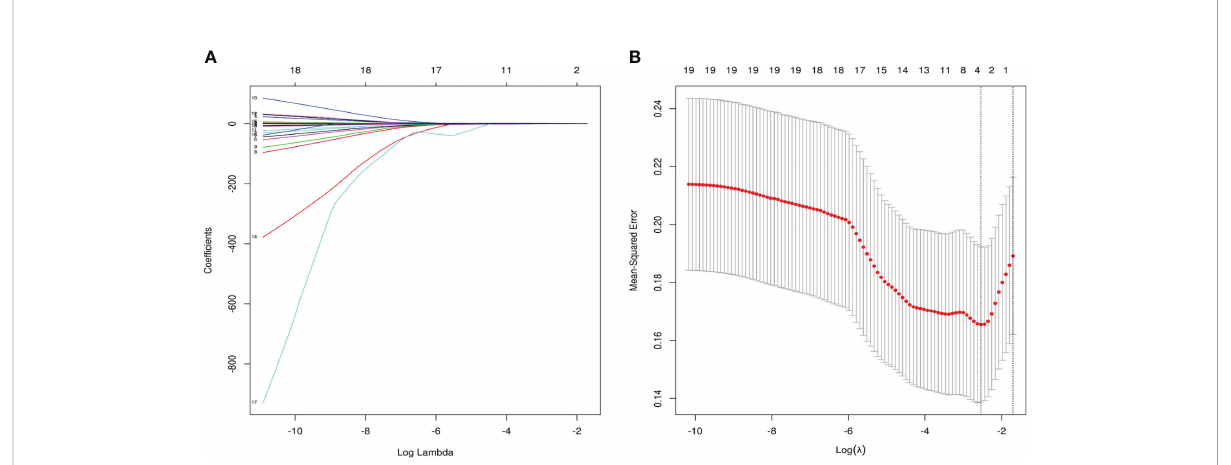
FIGURE 6 Variables were selected by least absolute shrinkage and selection operator (LASSO) regression. (A) Three clinical variables with nonzero coef fi cients were selected by optimal lambda ( l ). (B) 10-fold Cross-validation plot for the penalty term. The parameter l = 0.079 were selected via the minimum criteria.